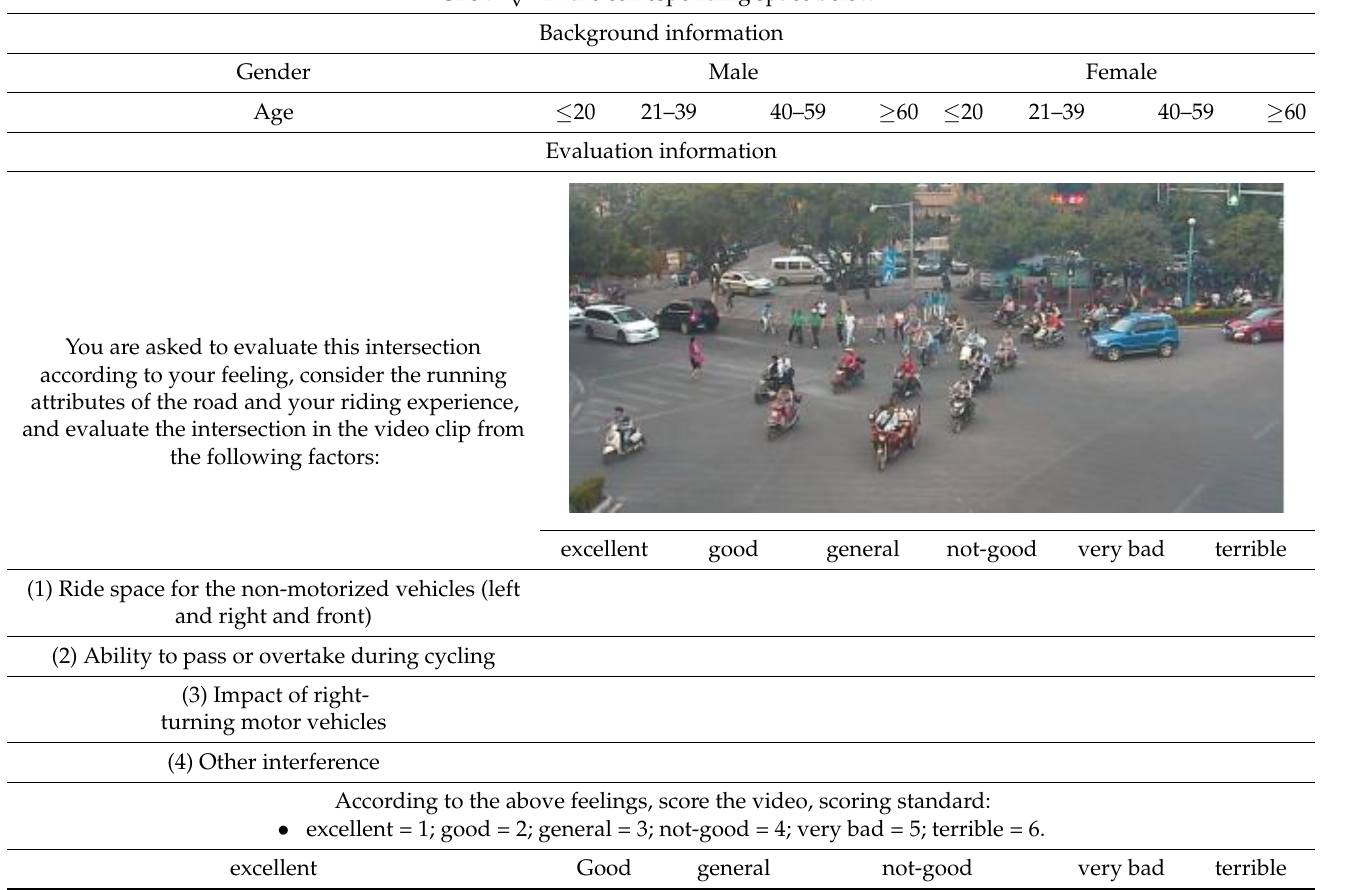
Table A1. Service Level Questionnaire. √ Click “ ” in the corresponding space